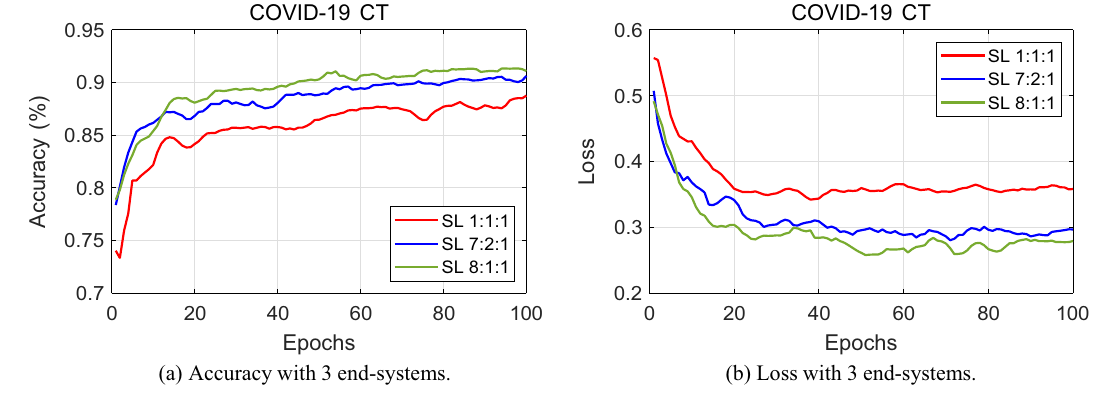
(a) .smetsys-dne3htiwssoL)b(.smetsys-dne3htiwycaruccA Figure 4. Performance tested with three end-systems. The graph depicts the classification results with three end-systems having 1:1:1, 7:2:1 and 8:1:1 data-imbalance.